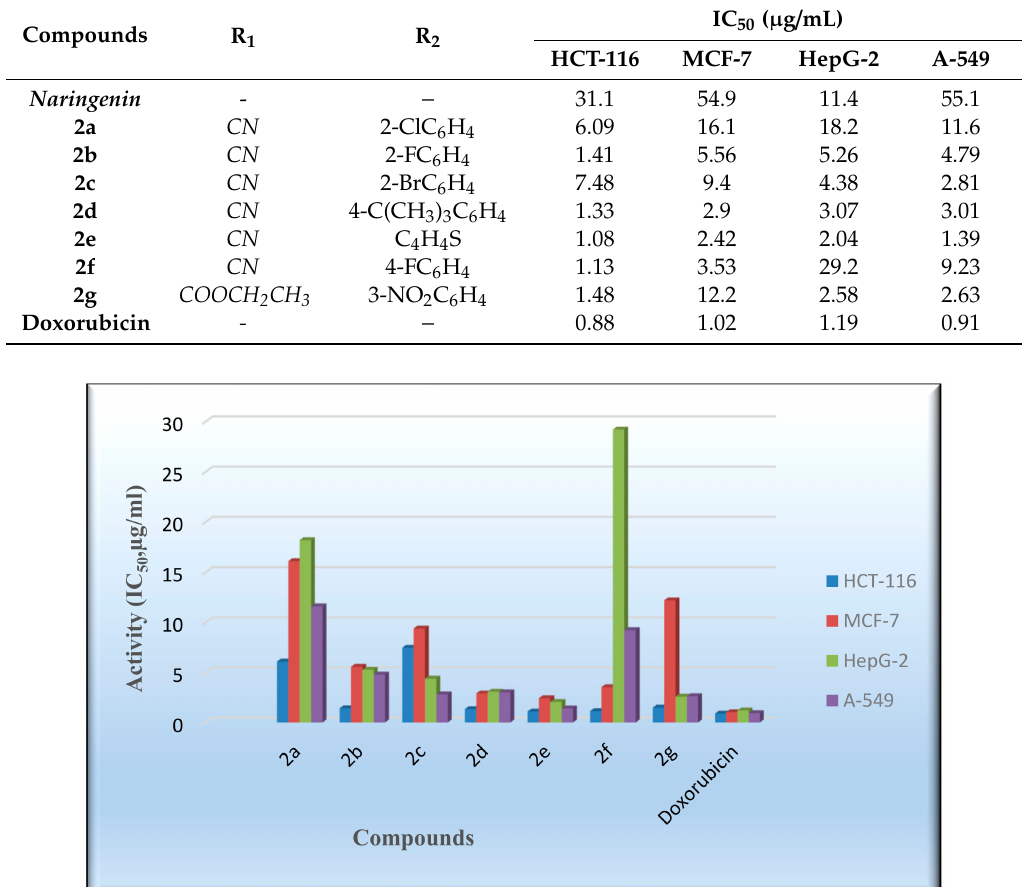
Figure 8. Evaluation of the cytotoxic activity of the flavanone-containing chromenes. HCT-116; MCF-7; HepG-2;